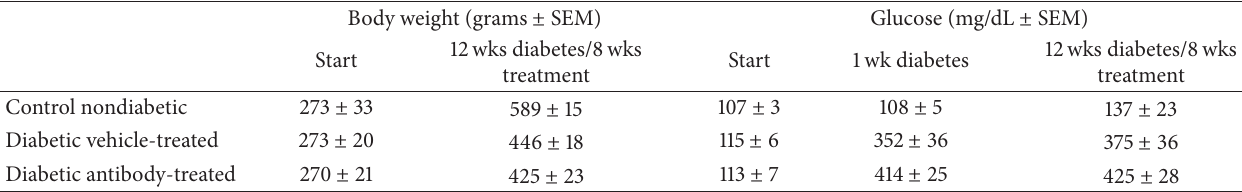
Table 1: Characteristics of study animals.